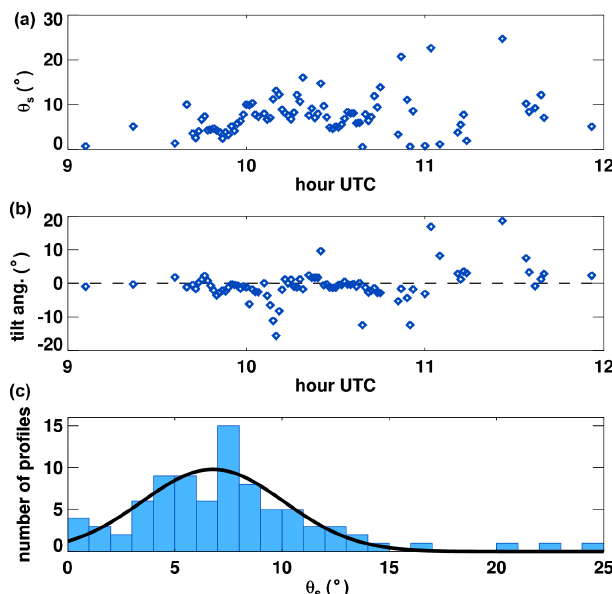
Figure 9. Aspect sensitivity of PMSEs in the zenith-wind vector plane as observed by NSMR. (a) Aspect sensitivity θ s of PMSE re- turn obtained from Gaussian curve fitted to PMSE Doppler power as a function of Doppler estimated zenith angle. (b) Center of Gaussian curve fitted to PMSE return peak power as a function of Doppler estimated zenith angle. (c) Histogram of PMSE backscatter θ s esti- mates. Gaussian fit to the distribution of estimates shown as a solid